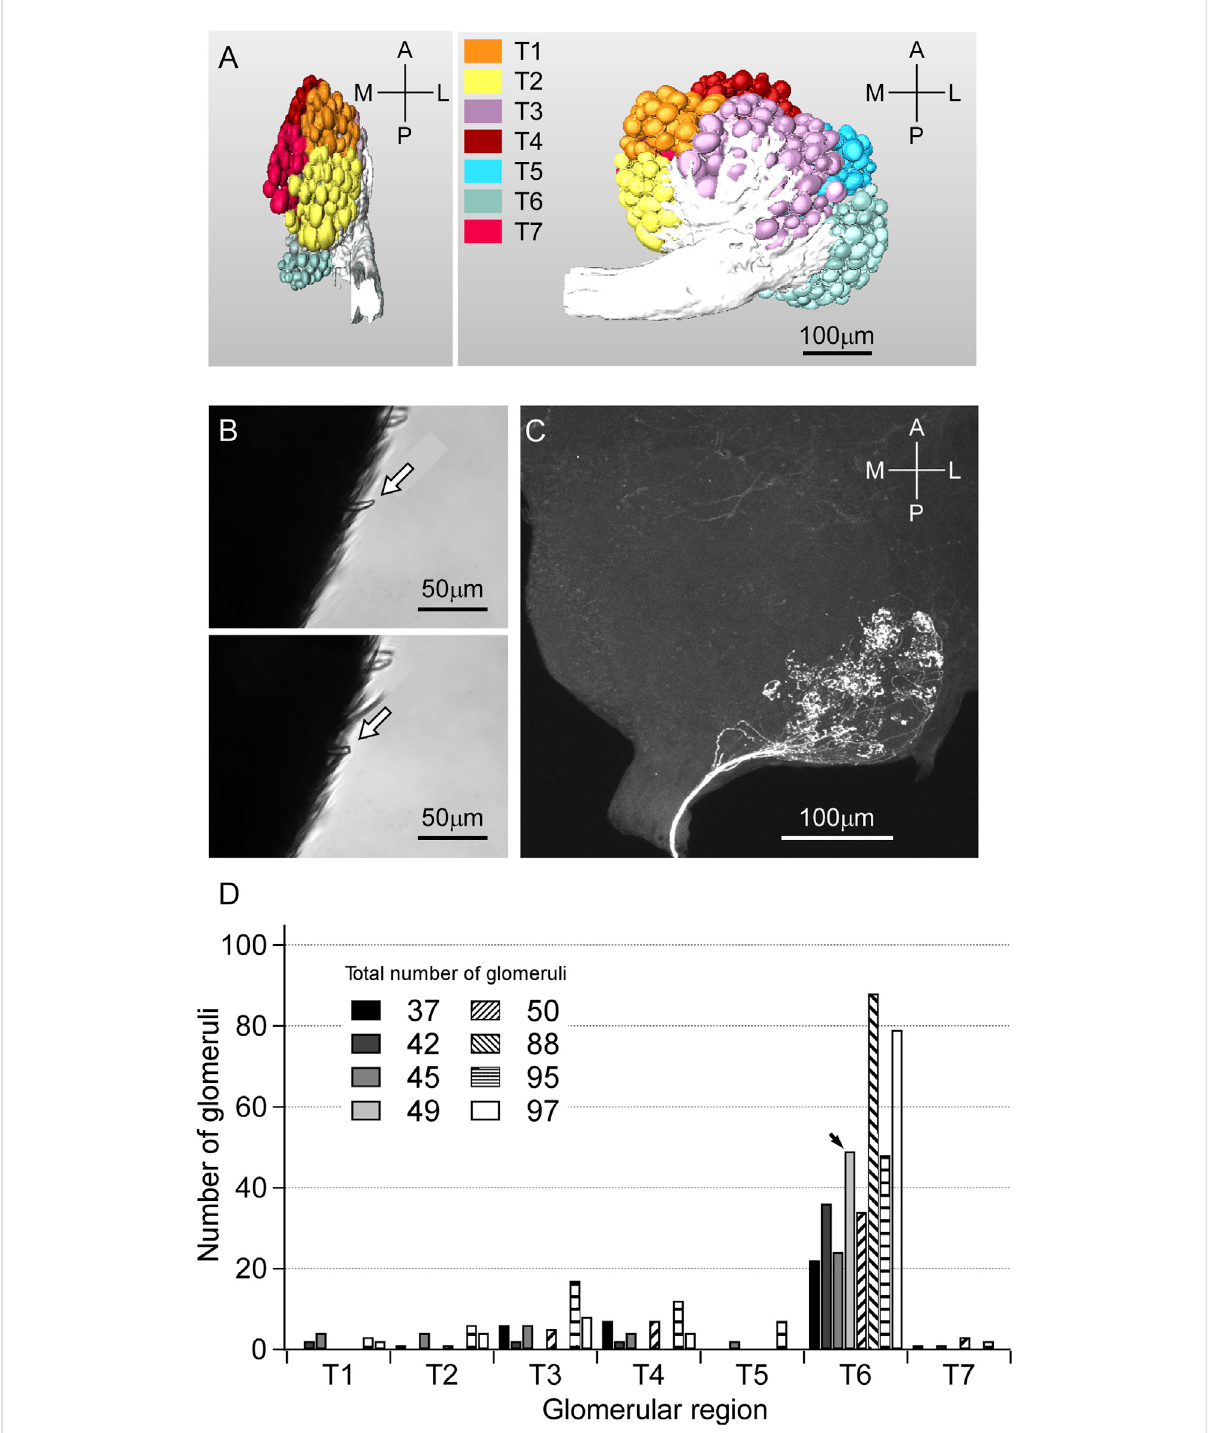
Glomerular map of C. japonicus and anterograde staining of the ORNs from a single s. basiconicum to AL. (A) (Left) Side view of the glomerular map. (A) (Right) Front view of the glomerular map. T1 − T7 regions of AL are differently colored; anterior-lateral (orange), lateral (yellow), anterior- ventral (purple), dorsal (brown), dorsomedian (blue), posterior-median (pale blue), anterior-lateral (red). (B) (Top, Bottom) A s. basicomicum before and after cutting for fl uorescent dye introduction, respectively (arrows). (C) The representative anterograde staining image of AL. Fluorescent dyewasintroducedfromasingles.basiconicum. (D) DistributionofnumberofglomeruliprojectedbythebasiconicsensillarORNsamongT1-T7( n = 8). In case of (C) , all of the 49 stained axons are projected to the T6 region